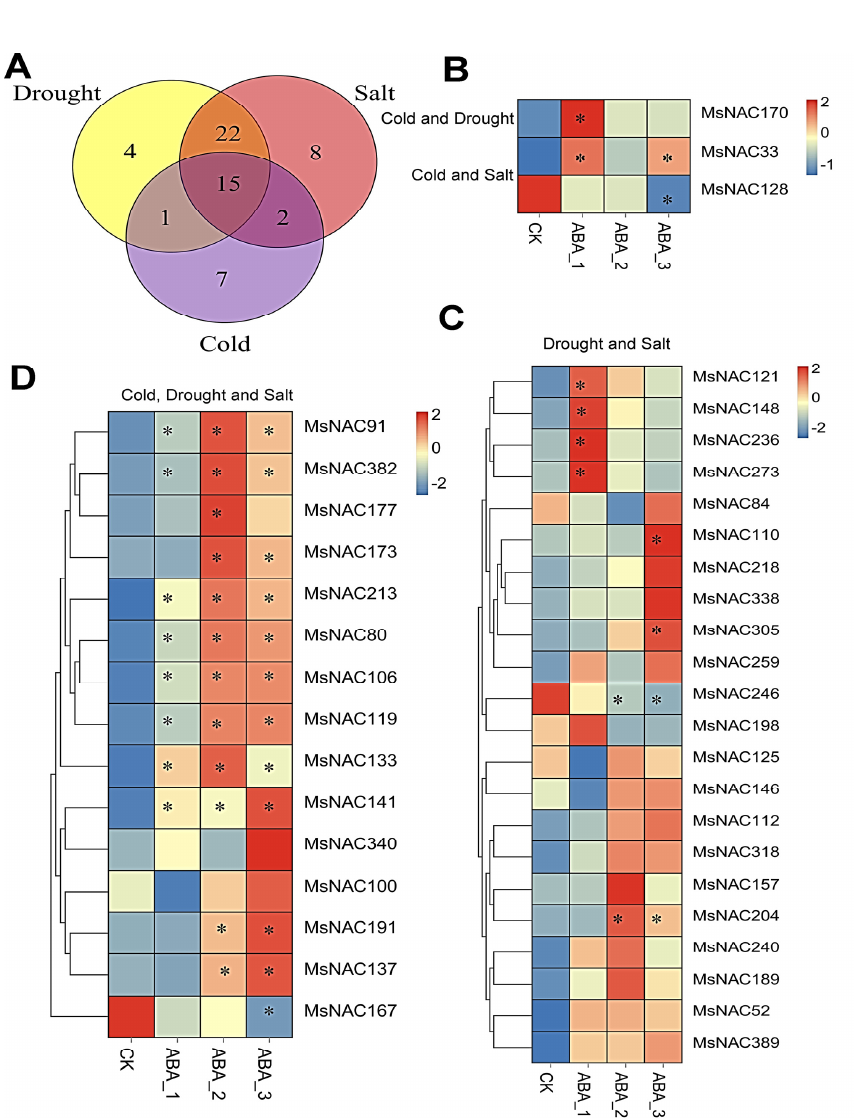
Figure 9. MsNAC genes that respond to multiple stresses. ( A ), Venn diagram of MsNAC genes responding to cold, drought and salt stress. ( B ), Three MsNAC genes ( MsNAC170, which responded to cold and drought stress, and MsNAC33 and MsNAC128, which responded to cold and salt stress) also responded to ABA treatment. ( C ), Expression analysis of 22 drought- and salt-responsive MsNAC genes under ABA treatment. ( D ), Expression analysis of 15 cold-, drought- and salt-responsive MsNAC genes under ABA treatment. The expression levels were normalized by row using the Z-Scores algorithm. The color scale at the right of the heatmap refers to the relative expression level, and the color gradient from blue to red presents an increasing expression level. * indicates a significant difference in expression based on padj < 0.05 and |log 2 FC| ≥